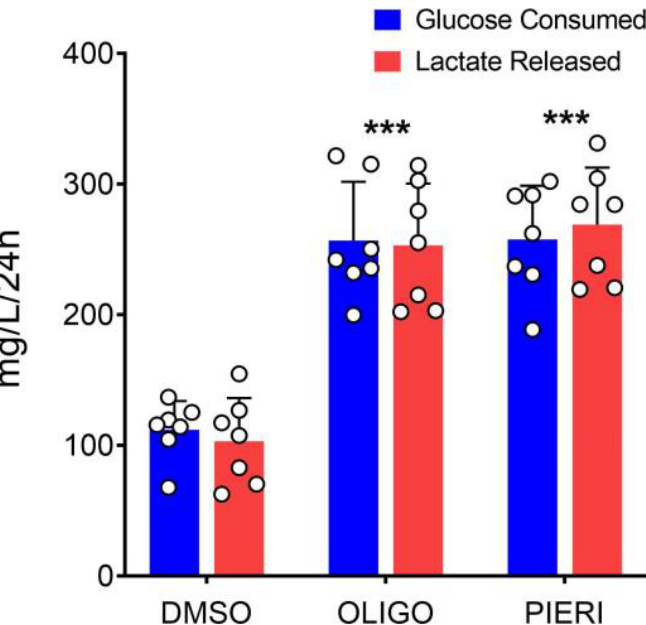
Figure 6. Glucose consumption and lactate released in astrocytes cultured in the presence of mito- chondrial inhibitors. Astrocytes were cultured in Medium 3, containing DMSO (0.025%, v/v ; solvent), oligomycin (OLIGO; 1 µ g/mL), or piericidin A (PIERI; 2 µ M) from day one (D1). Culture medium samples for glucose and lactate quantification were collected after 24 h of the addition of mitochon- drial inhibitors to cultured astrocytes. For more details, see Section 2. *** Statistically significant by one-way ANOVA and the Bonferroni compared to the respective DMSO condition ( p < 0.001). N =